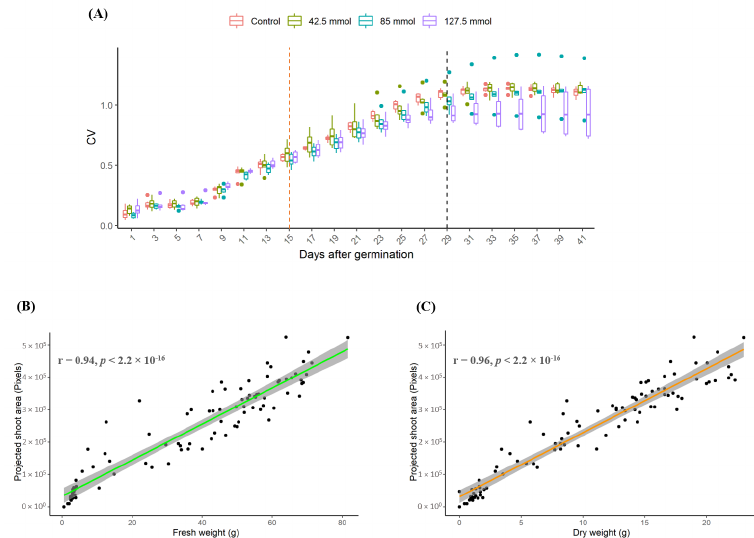
Figure 4. ( A ) Coe ffi cient of variation (CV) of projected shoot area overtime where the red line indicates the day of salt treatment commenced, ( B ) relationship between projected shoot area and fresh weight (g), and ( C ) relationship between projected shoot area and dry weight